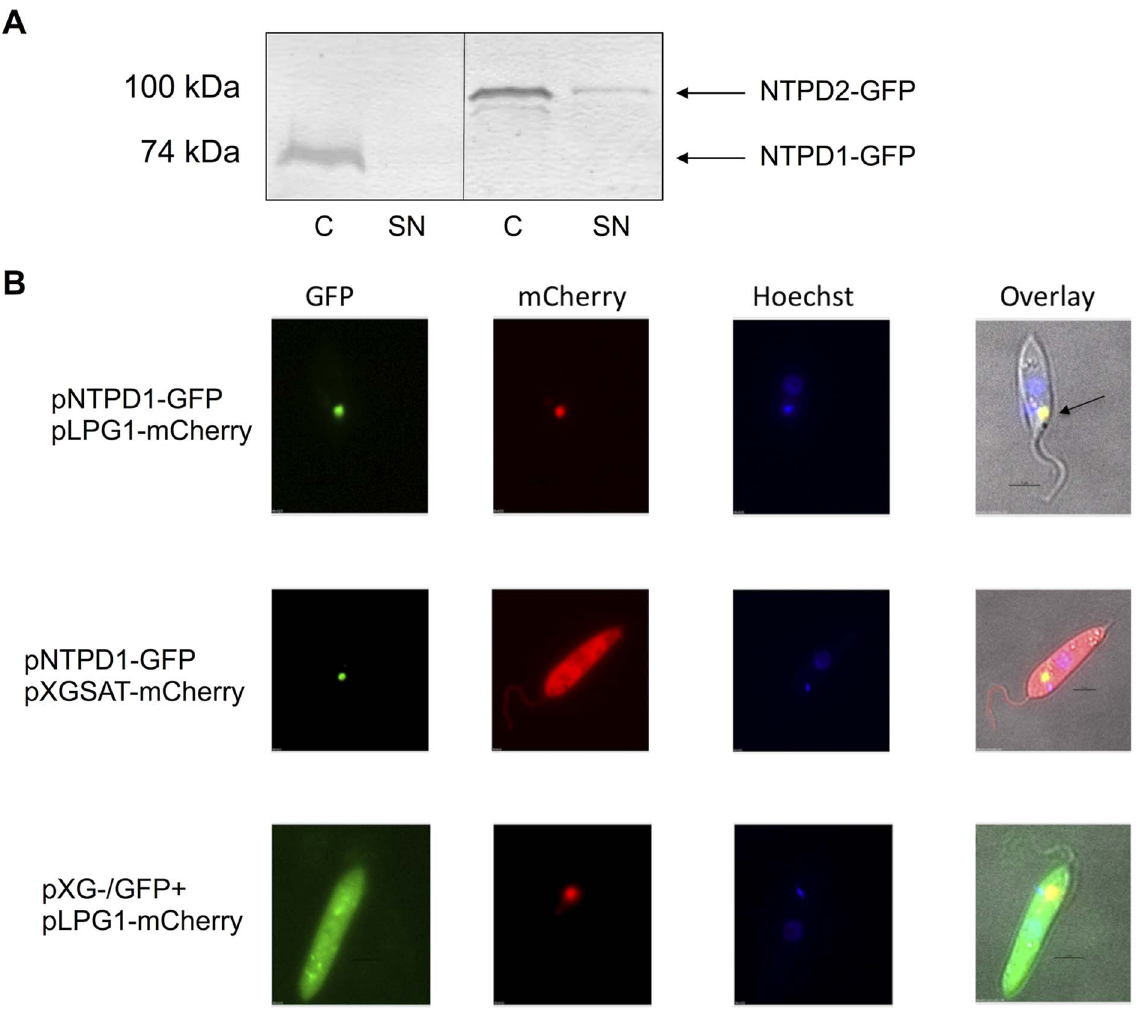
Fig. 2. Subcellular localization of LmNTPDase-GFP fusion proteins. A. Western blot using anti-GFP antibody demonstrating production of GFP-fusion proteins of the correct sizes by L. major parasites transfected with either pXG-NTPD1-GFP or pXG-NTPD2-GFP, and secretion of NTPD2-GFP into the culture supernatant. Lane 1: L. major + pXG-NTPD1-GFP (whole cell lysate, C), Lane 2: L. major + pXG-NTPD1-GFP culture supernatant (SN), Lane 3: L. major + pXG-NTPD2-GFP C, Lane 4, L. major + pXG-NTPD2-GFP SN. Samples were developed simultaneously on one membrane, with the vertical line representing removal of unrelated intervening lanes. B. Localization of NTPD1-GFP to the Golgi apparatus. Top panel: L. major co- transfected with pXG-NTPD1-GFP and pXG-LPG1-mCherry; middle panel: L. major co-transfected with pXG-NTPD1-GFP and pXG-SAT-mCherry; bottom panel: L. major co-transfected with pXG-/GFP + and pXG-LPG1-mCherry. Arrow indicates co-localisation of NTPD1-GFP and LPG1-mCherry in the Golgi apparatus. Hoechst staining highlights the parasite nucleus (diffuse staining) and kinetoplast (dense staining), with the Golgi apparatus (top and bottom panel, mCherry) in the region adjacent to the kinetoplast (as expected).